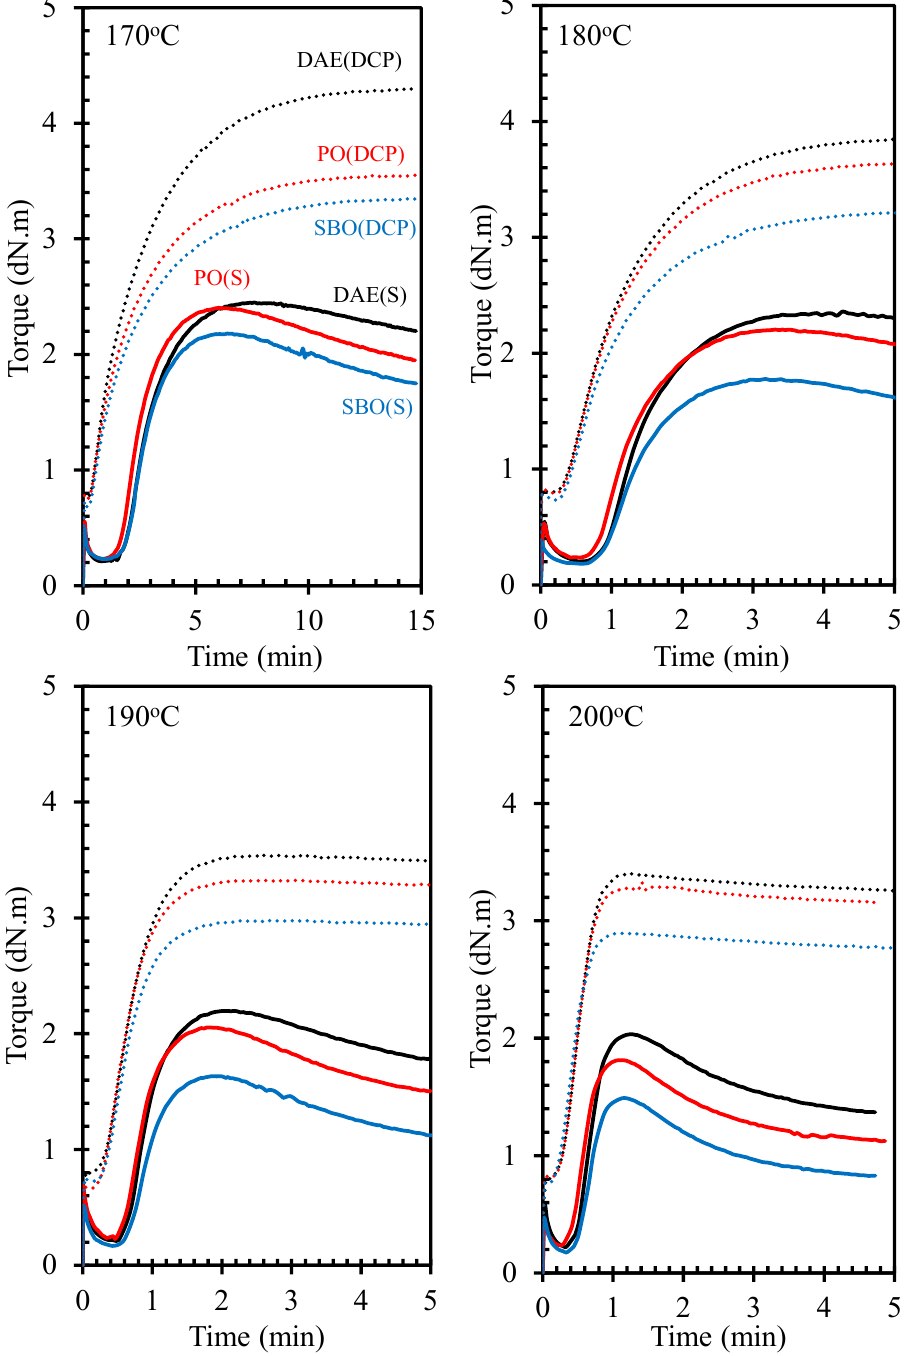
Figure 4. Torque – time curve of NR compounds containing different types of oils with various cur- Figure 4. Torque–time curve of NR compounds containing different types of oils with various ing systems. curing